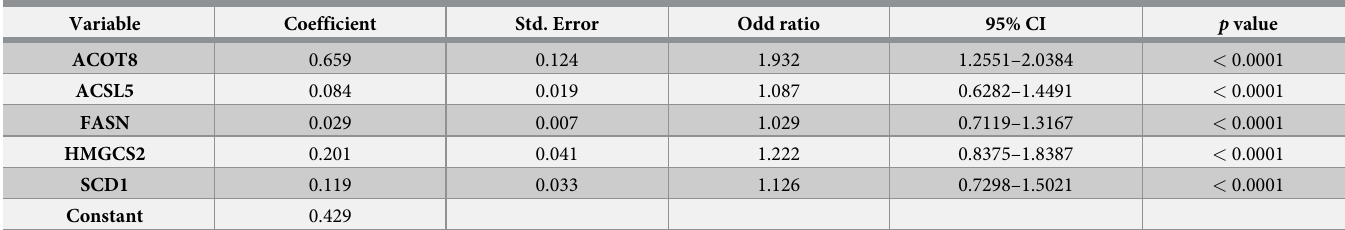
Table 3. Logistic regression of selected lipogenic genes and lipogenic genes panel in training set.